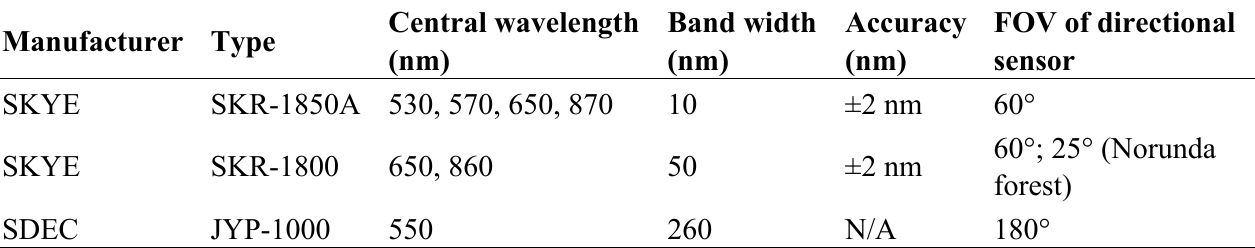
Table 2. Specification of the sensor